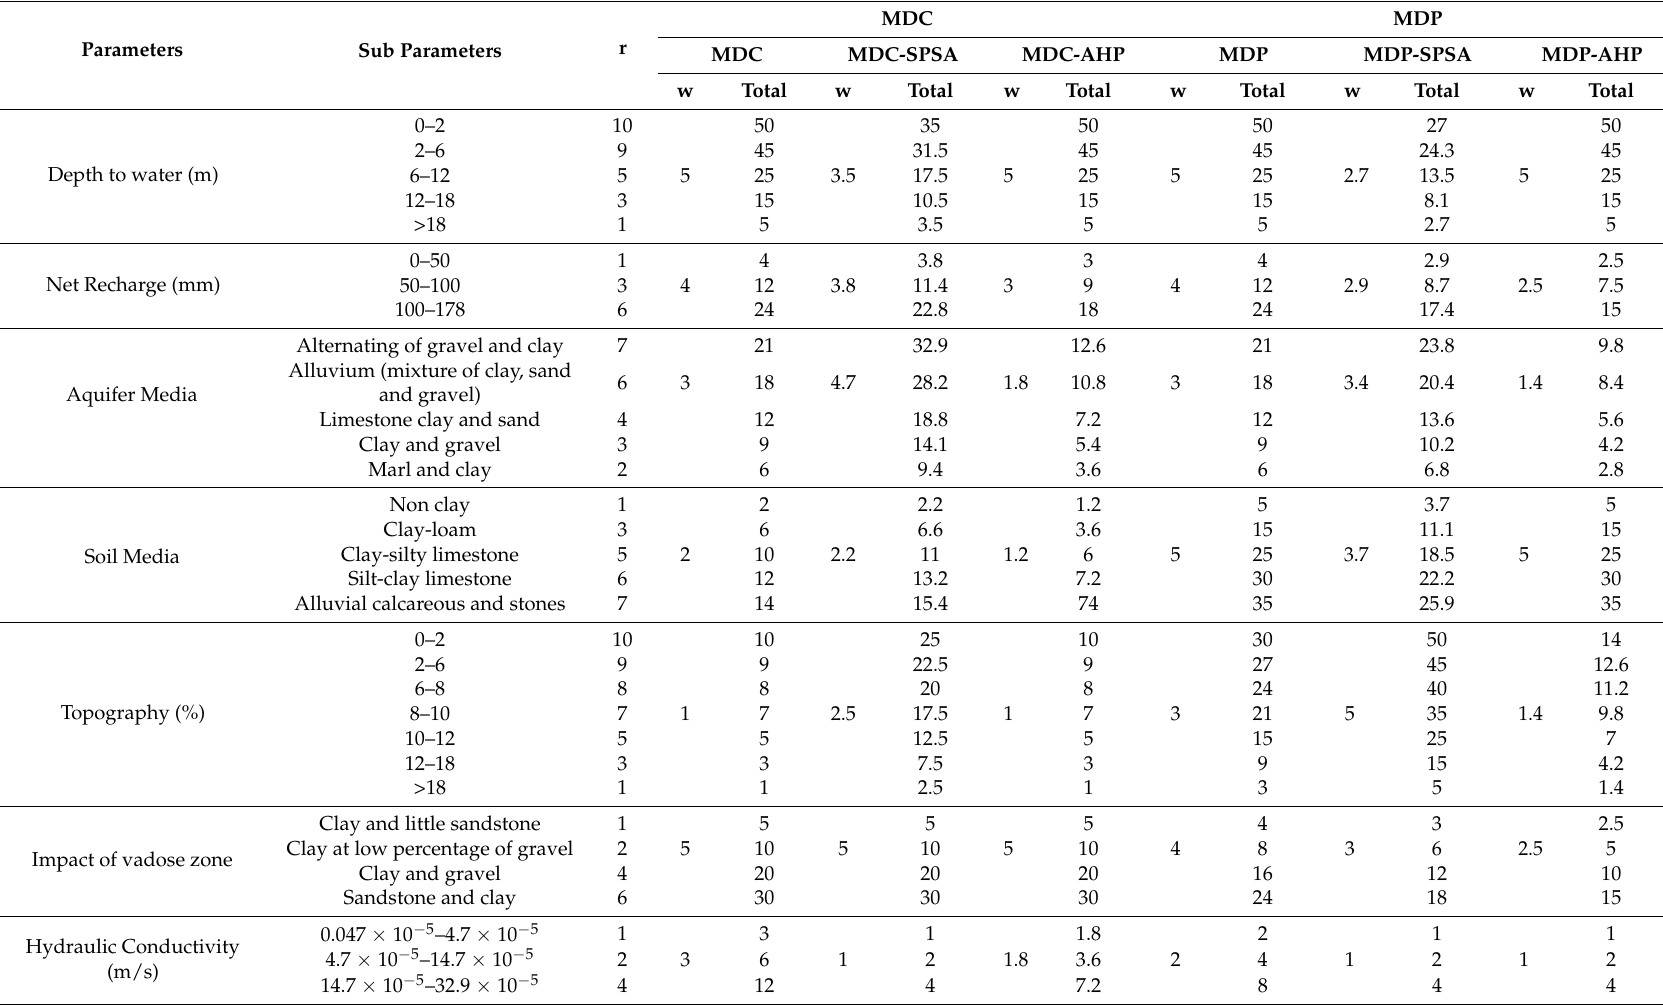
Table 6. Rating and weighting values used in the MDC, MDP, MDC–SPSA, MDP–SPSA, MDC–AHP and MDP–AHP